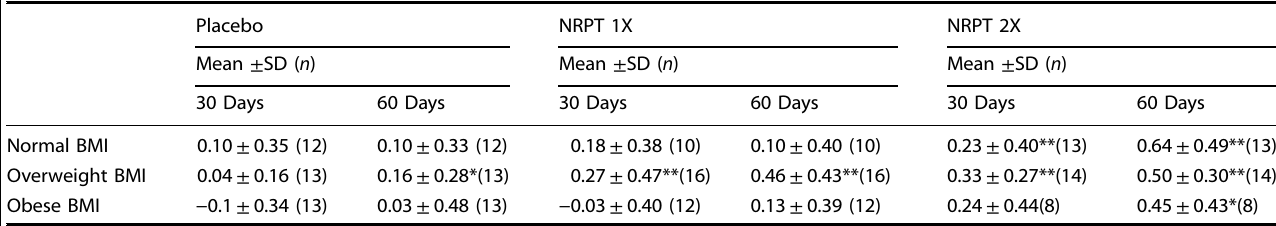
Table 4. Stratifying change in LDL at 30 and 60 days by BMI (normal, overweight, obese) in the ITT Population ( N =